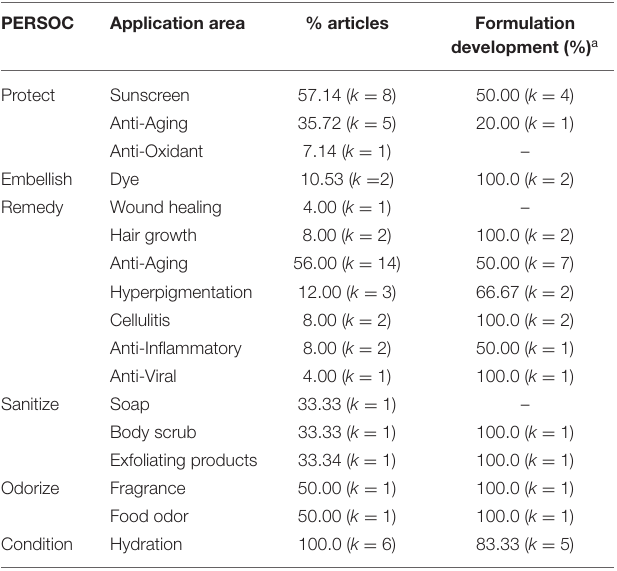
TABLE 7 | Application area of the selected papers according to the PERSOC classification and the percentage of formulation development in each segment.